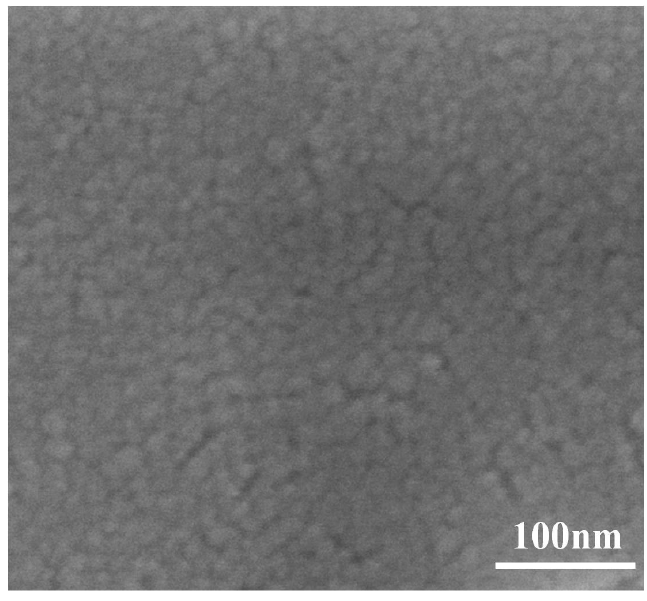
Figure 6. SEM morphology of the the IZTO film deposited at 100 W.